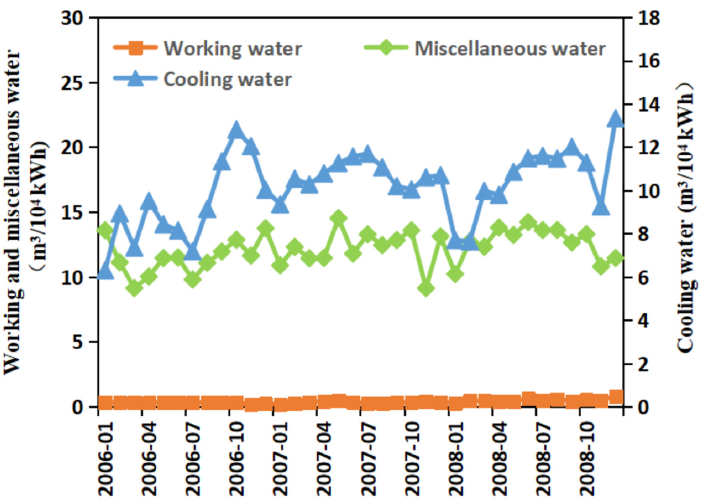
Figure 6. Water use efficiency in different sections for electricity generation at the Yueliangwan oil-fired power plant (from January 2006 to December 2008).